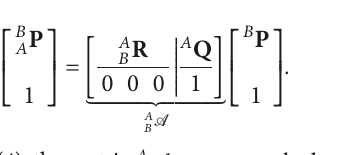
Figure 2: Homogenous transformation of the point A P by the rotation and translation